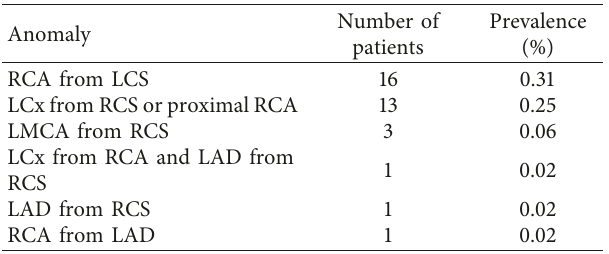
LAD: left anterior descending; LMCA: left main coronary artery; LCS: left coronary sinus; LCx: left circumflex; RCA: right coronary artery; RCS: right coronary sinus.